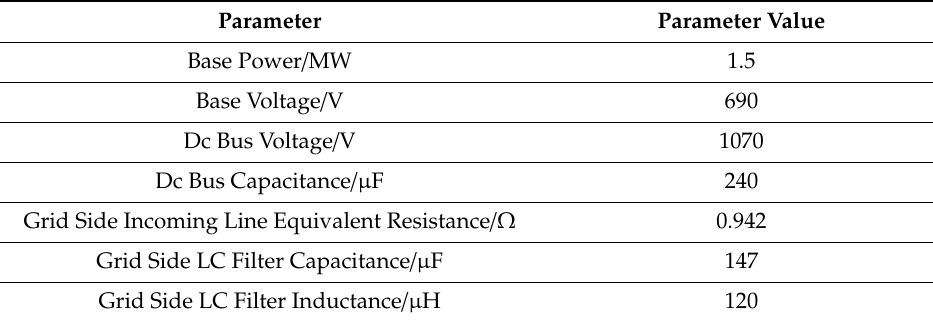
Table 1. Simulation parameters of 1.5 MW direct-drive permanent magnet generator.